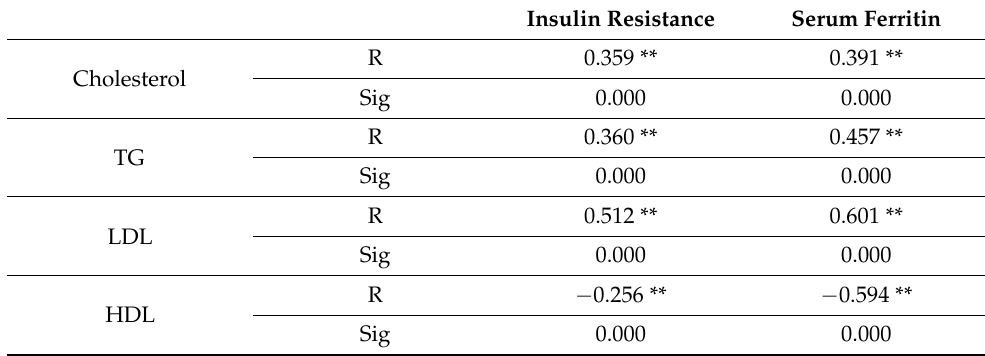
Table 3. Pearson correlation of the insulin resistance and serum ferritin with other parameters.